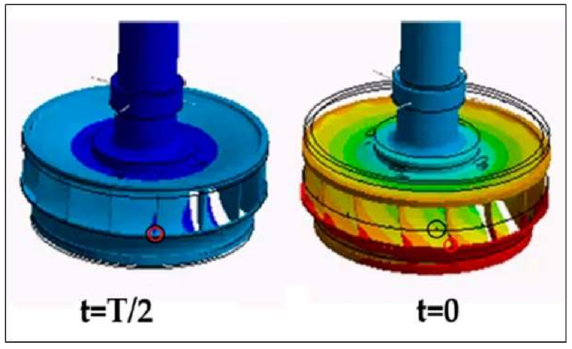
Figure 7. Torsion of the runner when the planar wave (peak of pressure) passes through it (t = 0).